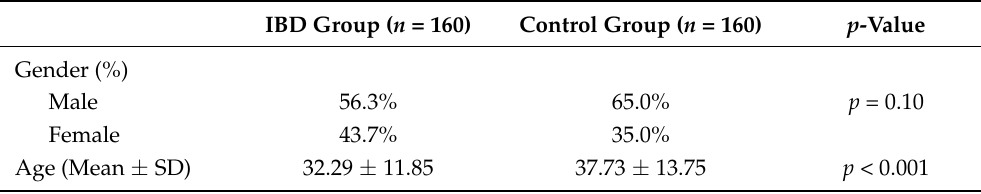
Table 1. Baseline characteristics of the IBD and control groups.